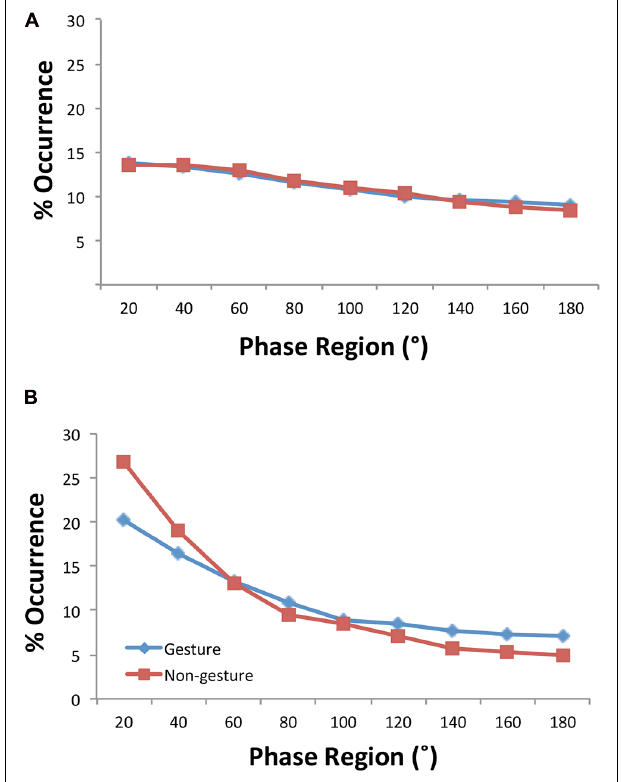
FIGURE 2 | Distributions of relative phase by motion conditions for the virtual (A) and experimental (B) participant pairs.